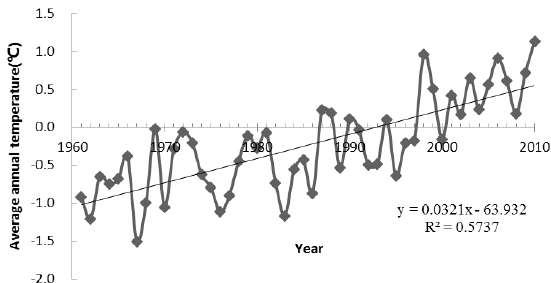
Figure 4. Annual average temperature change in Qinghai Lake basin from 1961 to 2010.